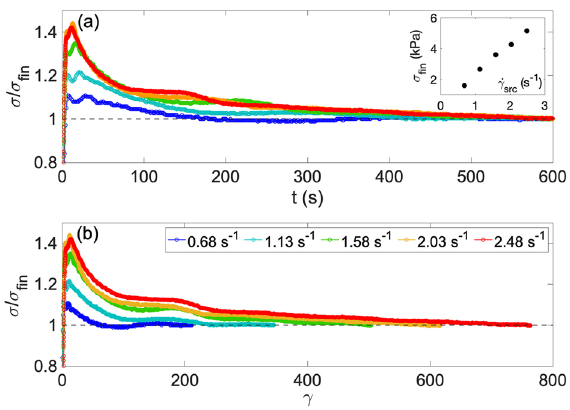
Figure 2. Results of SRC tests at various shear rates after pre-rest with t pr of 60 min and ˙ γ pr of 0 s −1 . ˙ γ src are indicated by the colors in the legend of ( b ). σ fin is the average value of the last 10 s. ( a ) Normalized shear stress vs. time. The inset shows the relation between the final stress σ fin , and the shear rate ˙ γ src , and the standard deviation of σ fin is included in the circle. ( b ) Normalized shear stress vs.